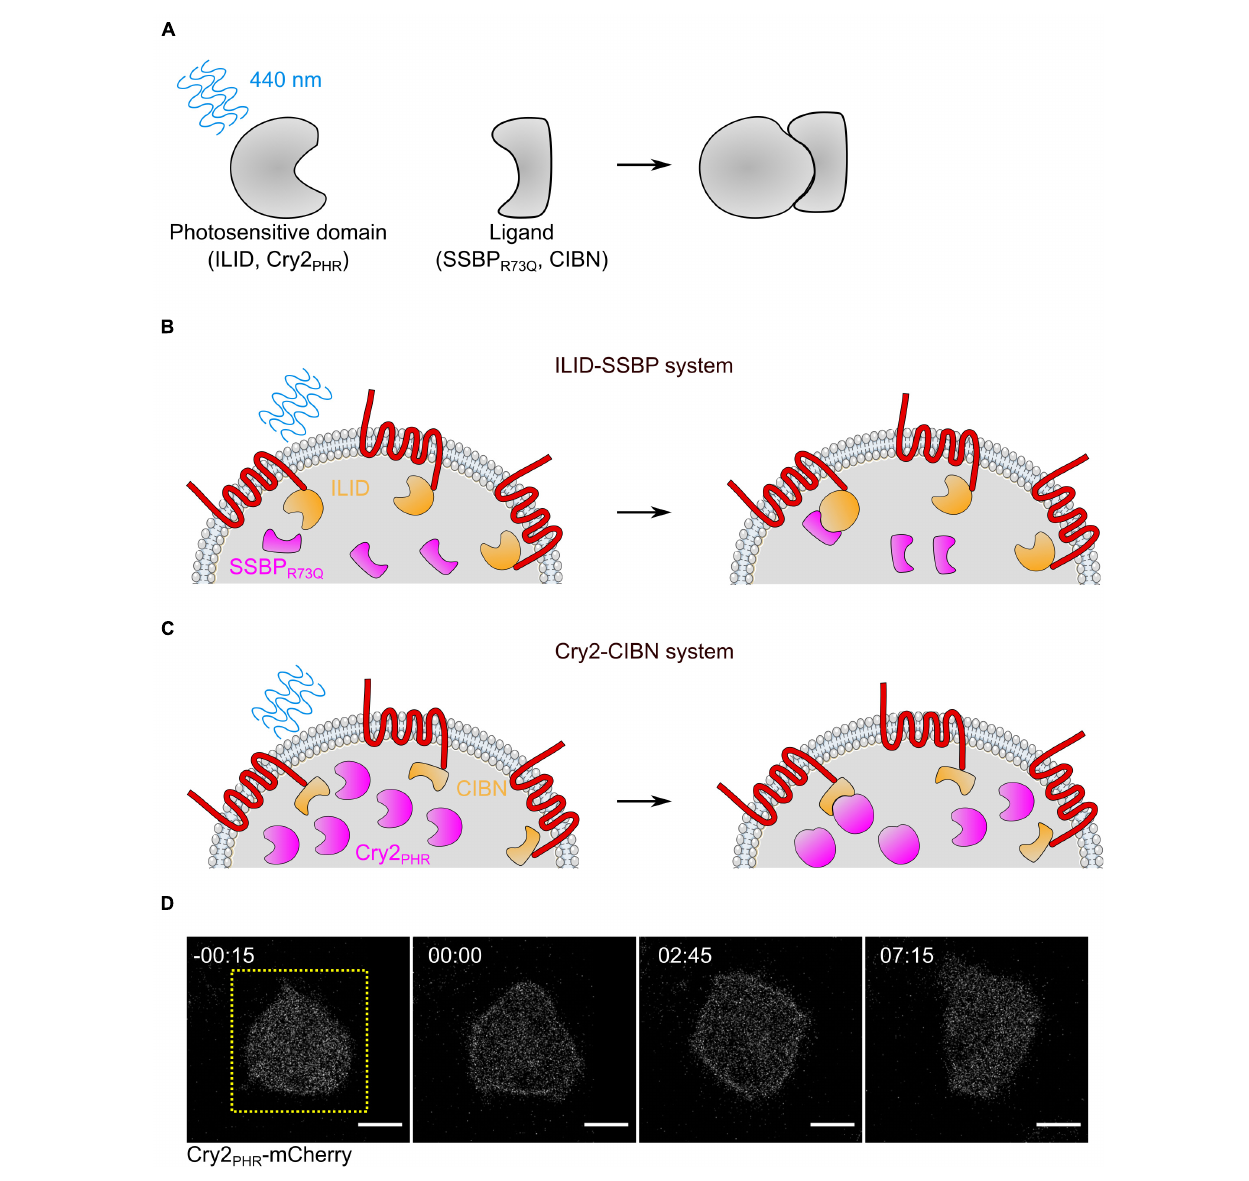
FIGURE 5 | Optogenetic systems for controlling protein localization in Dictyostelium. (A) Diagram of blue light dimerization systems. In the dark, a photosensitive protein (iLID or Cry2 PHR ) has low affinity for its ligand (SSBP R 73 Q or CIBN, respectively). When exposed to 450 nm light, a conformational change in the photosensitive domain allows it to bind to the ligand with affinity. (B,C) Diagram of iLID-based (B) and Cry2-based (C) systems for recruiting proteins to the membrane in Dictyostelium . The actuator (magenta) is recruited to the uniformly distributed membrane anchor (orange) only at the area exposed to blue light. Note that in the iLID system, the photosensitive protein is attached to the membrane anchor, while in the Cry2 system, it is attached to the cytosolic actuator. (D) Scanning confocal imaging of Cry2 PHR membrane recruitment in AX3 Dictyostelium cells. Cells are also expressing an unlabeled membrane anchor, cAR1-CIBN. Yellow dashed square indicates region illuminated with 488 nm light. Scale bars = 5 µ m. t = 00:00 indicates blue light